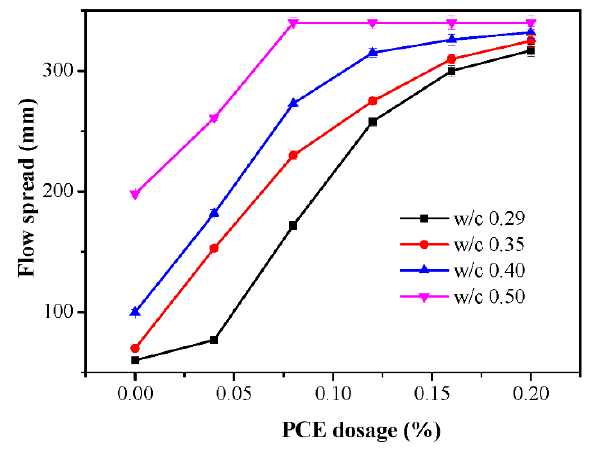
Figure 7. Variations of the flow spread with w/c for different PCE contents.